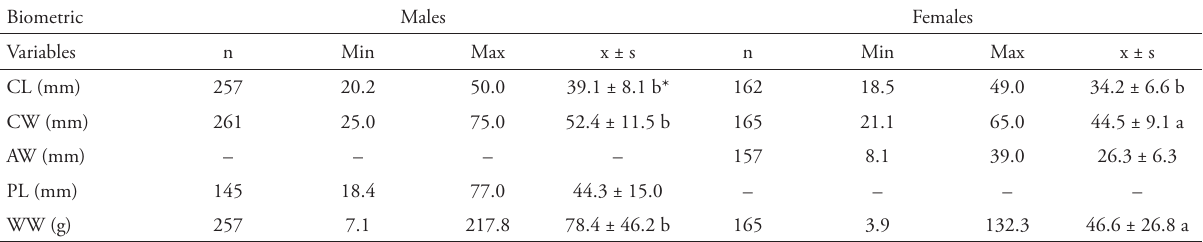
Table 2. Ucides cordatus (Linnaeus, 1763). Biometric variables, including the cephalothorax (CW, width; CC, length), the length of the propodus of the major cheliped (PL, for males only), the width of the 5 th somite of the abdomen (AW, for females only) and the wet weight (WW), based on the individuals captured monthly in mangroves of the Joanes River, Lauro de Freitas Municipality (Bahia State, Brazil) between September 2011 and August 2012. An n indicates the number of specimens measured and weighed, Min is the minimum value, Max is the maximum value, x is the mean, and s is the standard deviation.